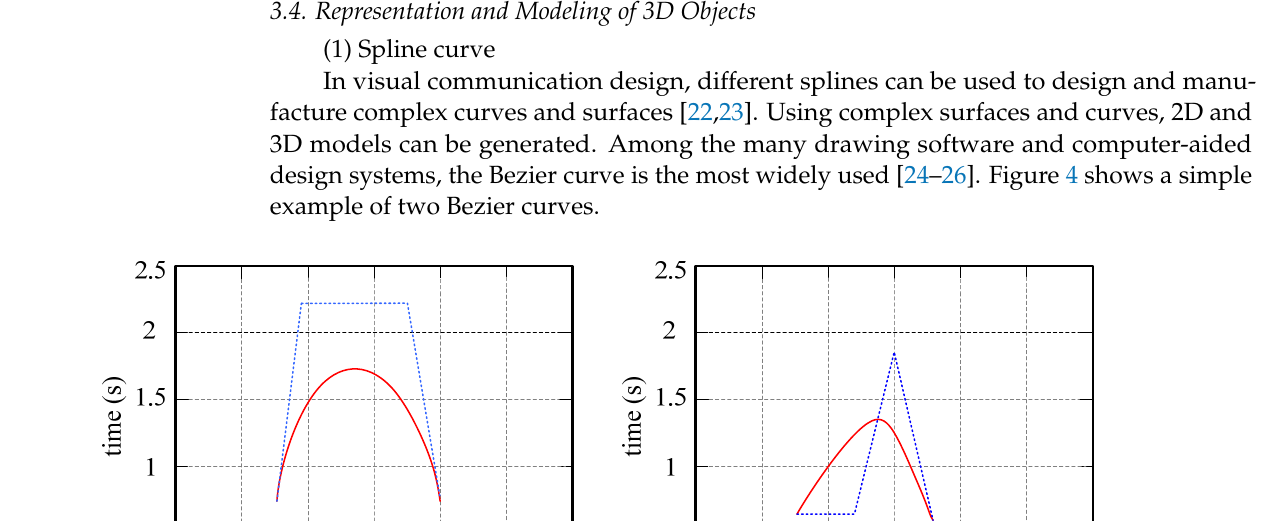
Figure 3. Flowchart of the blending operation.